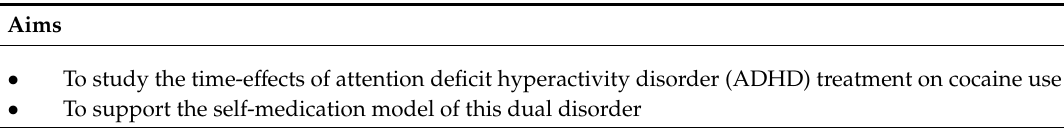
Table 1. Aims, data gathered, and future